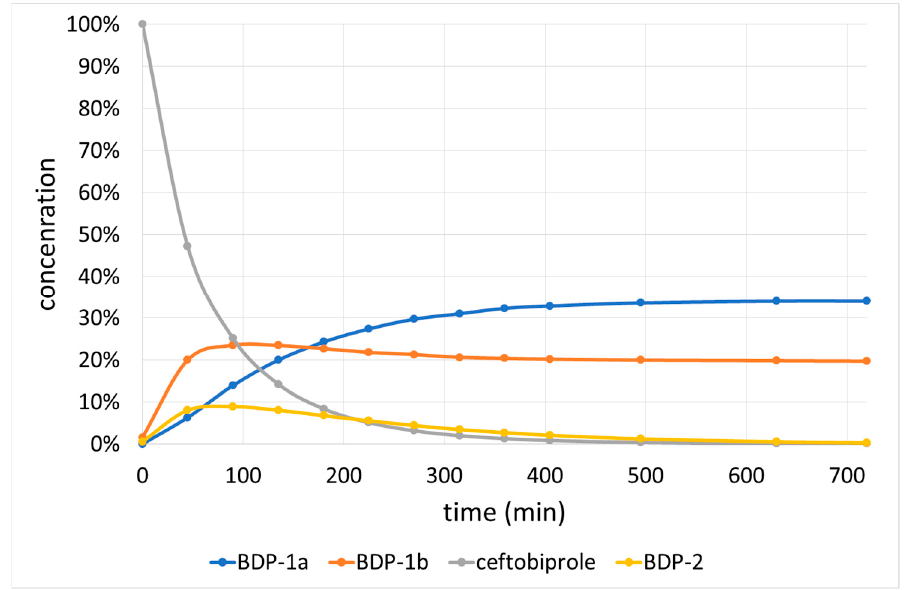
Figure 6. Time dependence of ceftobiprole decomposition in 0.01 M NaOH.